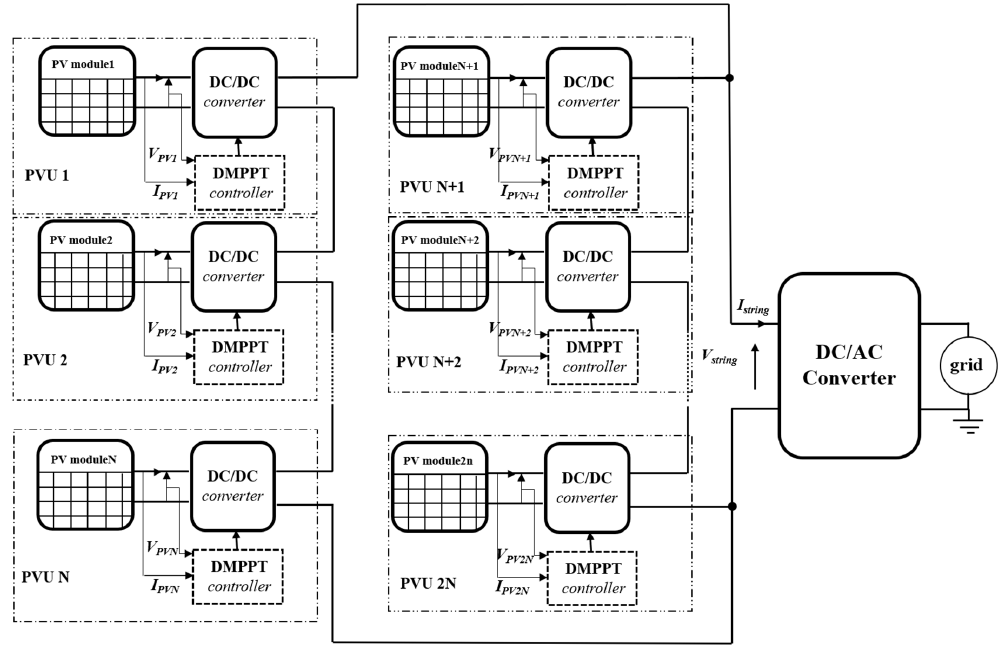
Figure 1. Grid-connected PhotoVoltaic (PV) system with Distributed Maximum Power Point Tracking (DMPPT).